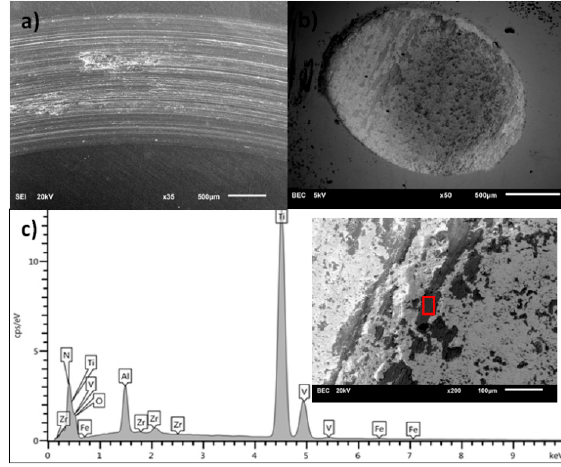
Figure 10. ( a ) Wear track on the surface of nitrided Ti-6Al-4V sample, ( b ) wear scar on the ZrO 2 ball surface, ( c ) the EDS analysis of the surface of ZrO 2 counterbody (inset with square shows the place of analysis).